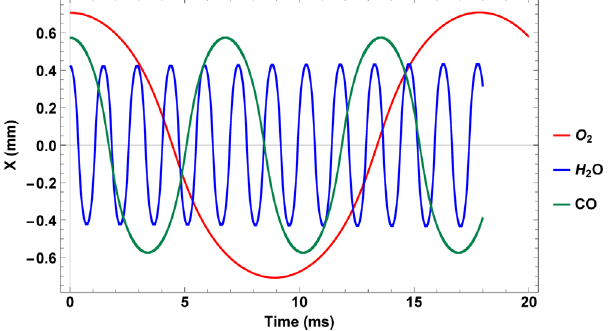
FIG. 5. Motion of neutral molecules initially 1 mm from the beam, at rest, and subjected to the electromagnetic field of the beam, as seen in the horizontal direction. Different colors correspond to different molecules as indicated.